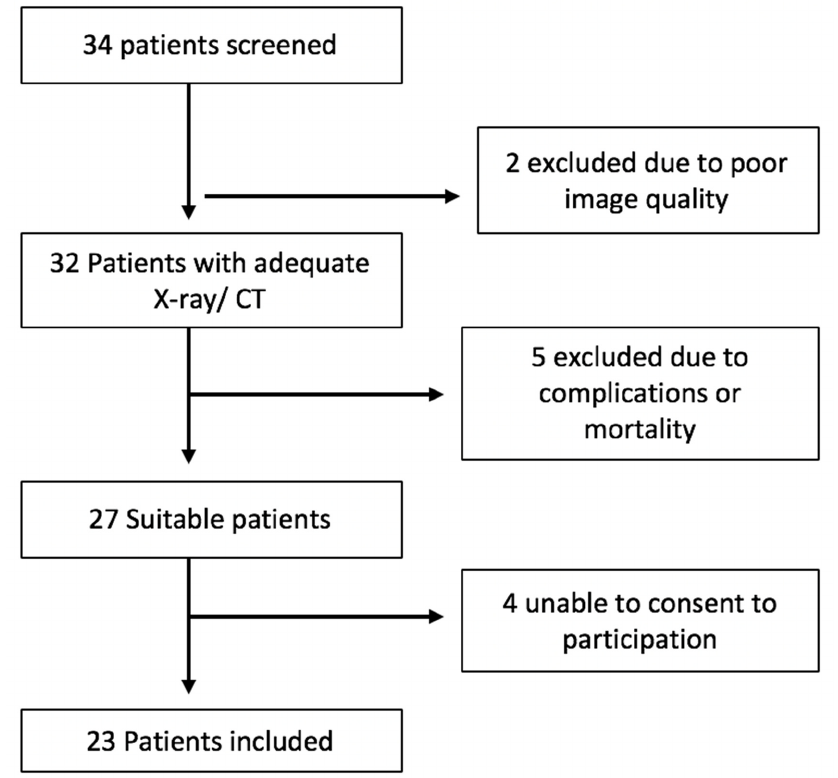
Figure 1. Inclusion criteria flow-chart.